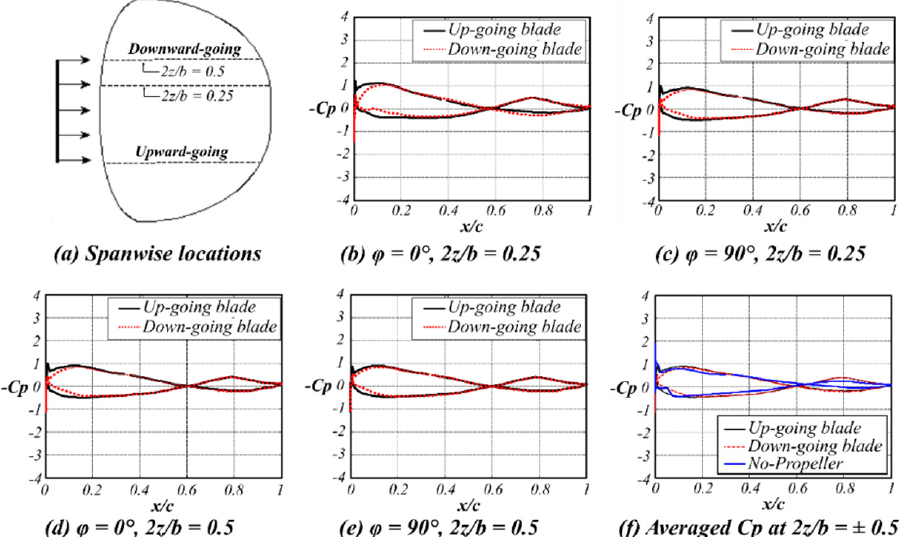
Figure 8. Instantaneous and averaged C p distributions at various spanwise location with α = 0 ◦ and ω = 555 rad/s, ( a ) MAV wing spanwise locations, ( b , c ) wing spanwise location of 2z/b = 0.25 and propeller zimuth angle of 0 ◦ and 90 ◦ , ( d , e ) wing spanwise location of 2z/b = 0.5 and propeller zimuth angle of 0 ◦ and 90 ◦ , ( f ) pressure coefficient comparison between isolated wing and wing-MAV at spanwise location of 2 z / b = ± 0.5